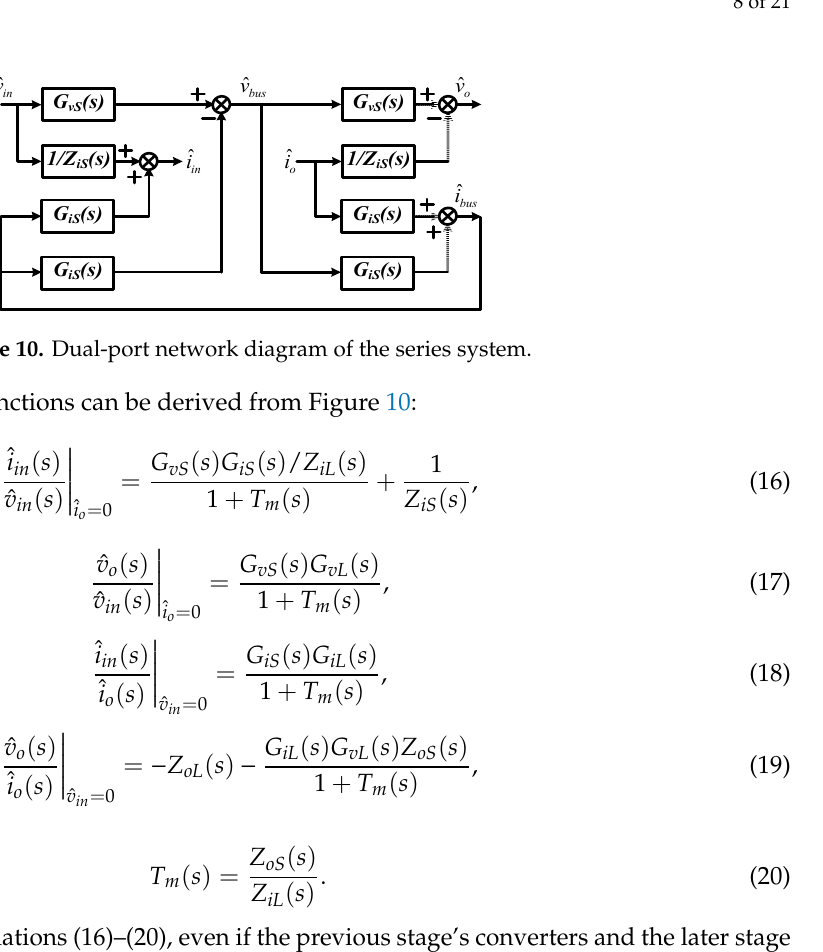
Figure 9. Schematic diagram of a typical series system.